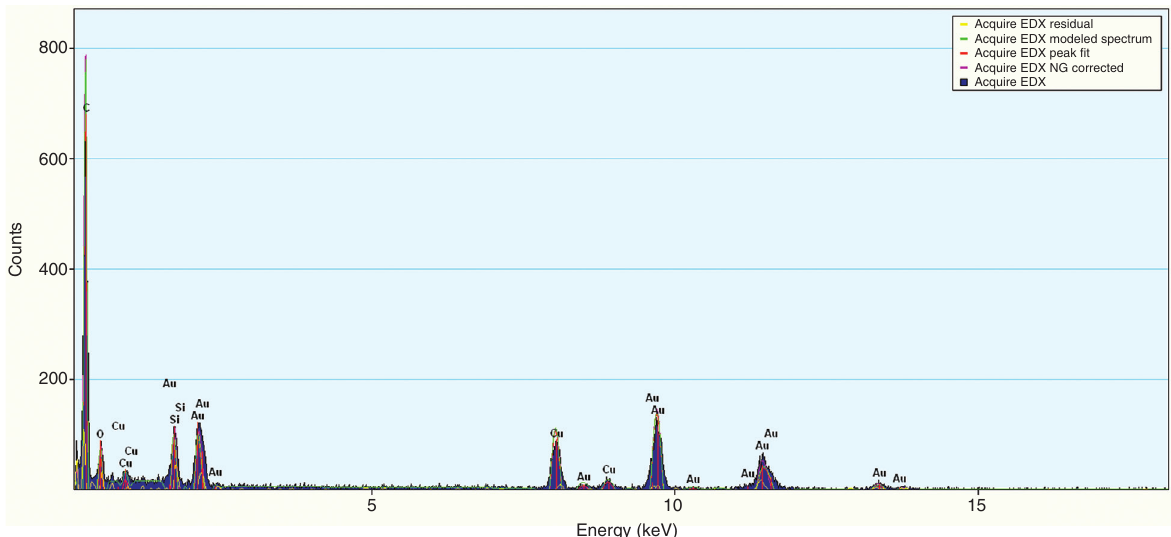
Figure 8 Representative energy dispersive X-ray analysis (EDAX) profile of gold